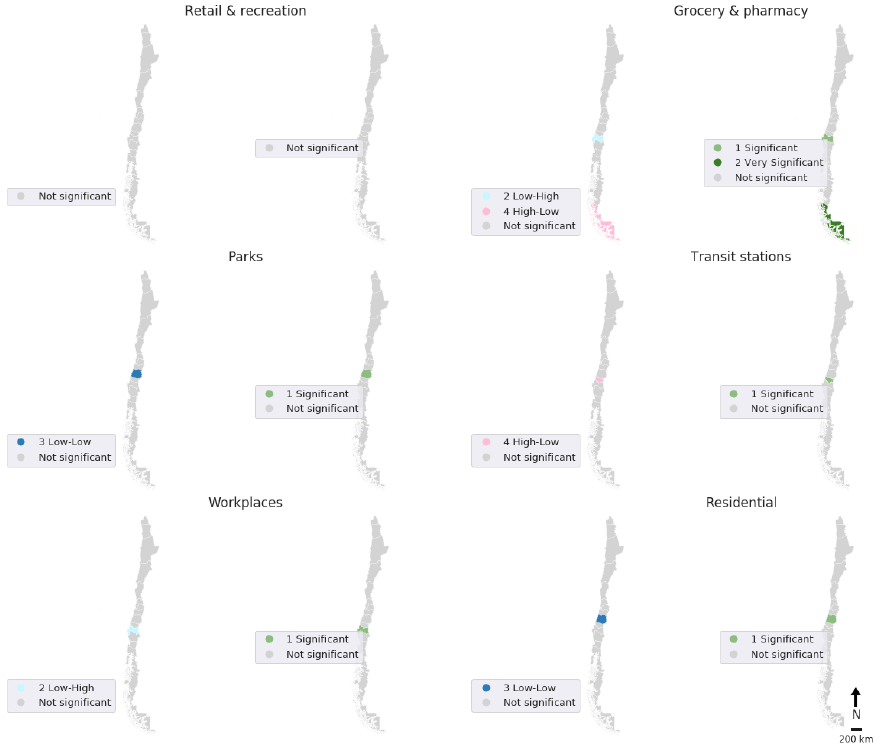
Figure 23. Cluster maps and LISA significance maps for Google categories from 15 February to 31 May 2020: Chile. Source of basic data: Covid-19 Community Mobility Reports, Google.